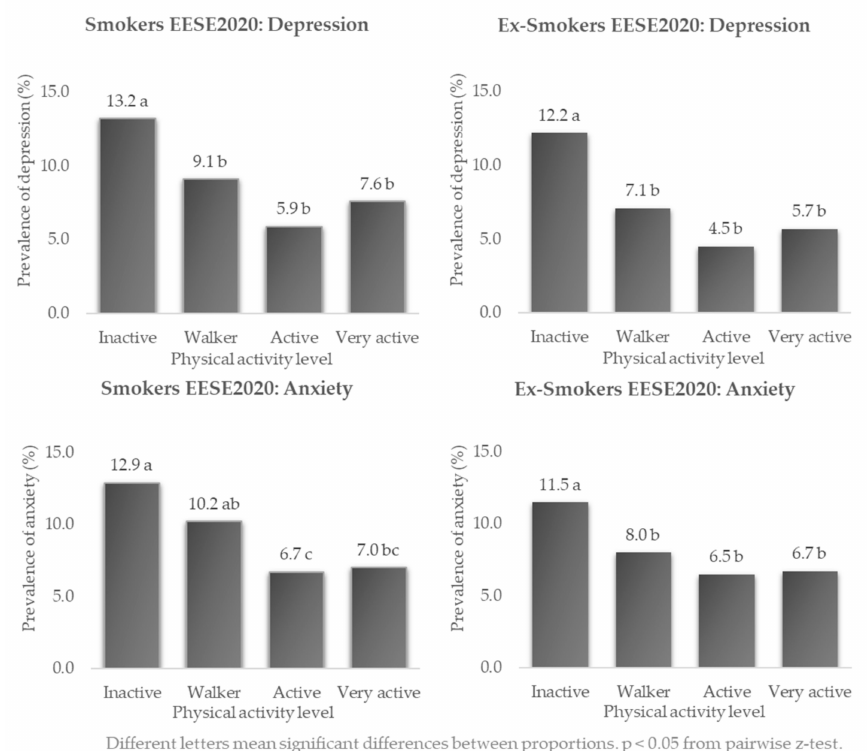
Figure 5. Prevalence of depression and anxiety in Spanish smokers and ex-smokers according to their frequency of physical activity: